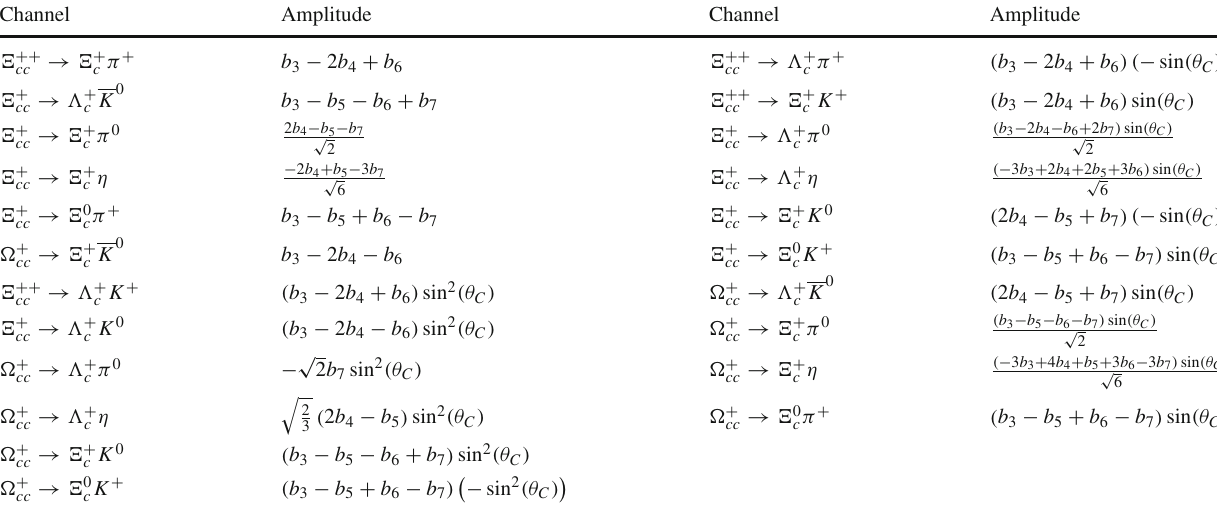
Table 5 Doubly charmed baryons decays into a cqq (antitriplet) and a light meson Channel Amplitude